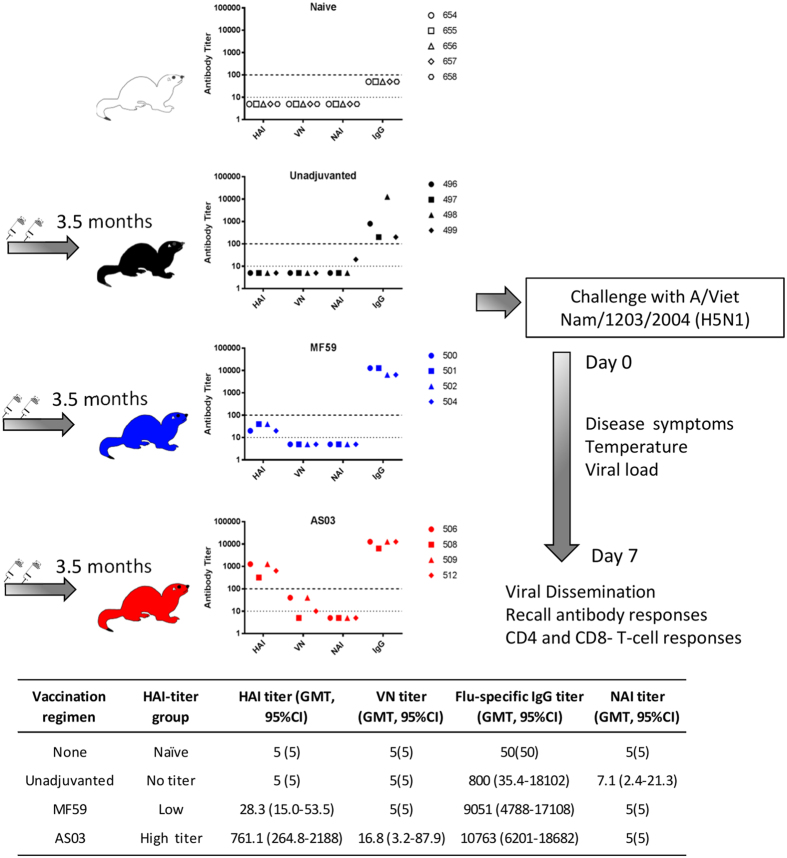
Schematic of experimental design and the antibody profile of each individual ferret prior to challenge.Ferrets were vaccinated with 2 doses of monovalent A/Viet Nam/1203/2004 (H5N1) (Sanofi-Pasteur) 3.5 months prior to challenge with homologous wild-type virus. Graph indicates the pre-challenge antibody titers measured at 3 months post-vaccination by hemagglutination-inhibition assay (HAI), virus neutralization (VN) assay, neuraminidase-inhibition (NAI) assay, and ELISA for vaccine-specific IgG-antibodies. Dashed line at Y = 10 indicates detection threshold for HAI, VN and NAI, while dashed line at Y = 100 indicates detection threshold for flu-specific IgG. Individual ferrets are assigned its respective symbol within its vaccine group (colored as ○ for naïve, ● for unadjuvanted,  for MF59 and  for AS03) and is tracked as such for the remainder of this manuscript. Summary statistics for the antibody titers (expressed as Geometric Mean Titers, GMT with 95% Confidence Intervals) are as listed in the summary table.